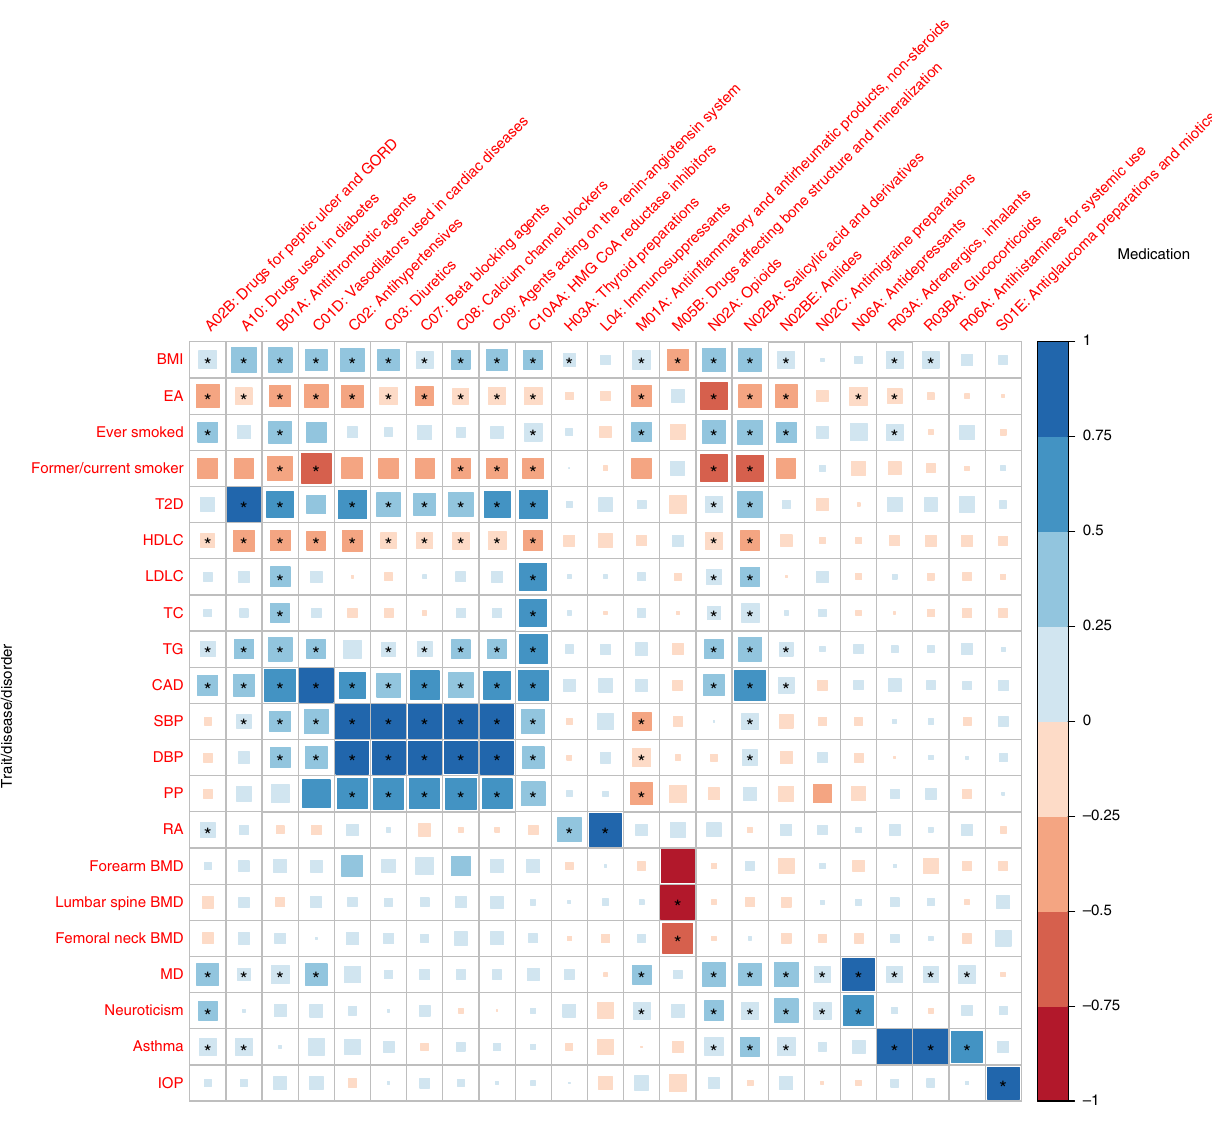
Fig. 4 Genetic correlation of the 23 medication-taking traits and 21 diseases/traits. Rows represent traits from Supplementary Table 3 and columns represent 23 medication-taking traits. The size and colour of each square in each cell represent genetic correlation with right-side bar as reference. The signi fi cant genetic correlation after correcting for 483 tests ( P ≤ 1.0 × 10 − 4 ) are labelled with an asterisk. Abbreviations: Body mass index (BMI), Educational attainment (EA), Type 2 diabetes (T2D), High-density lipoprotein cholesterol (HDLC), Low-density lipoprotein cholesterol (LDLC), Total cholesterol (TC), Triglyceride (TG), Coronary artery disease (CAD), Systolic blood pressure (SBP), Diastolic blood pressure (DBP), Pulse pressure (PP), Rheumatoid arthritis (RA), Bone mineral density (BMD), Major depression (MD), Intraocular pressure